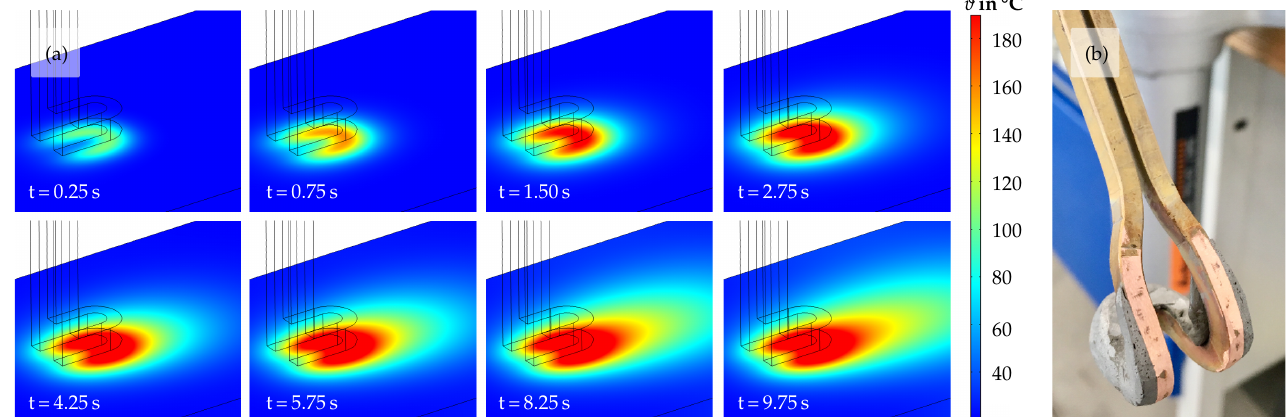
Figure 6. ( a ) Temperature distribution in the substrate over time when heated with a C-shaped inductor coil. ( b ) View of the fabricated C-shaped inductor for welding